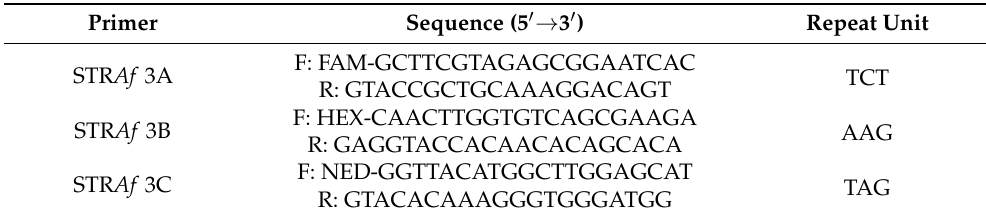
Table 2. Primers’ sequences, fluorophores used, and respective repeat units amplified (based on [32]). Primer Sequence (5 (cid:48) → 3 (cid:48) ) Repeat Unit STR Af